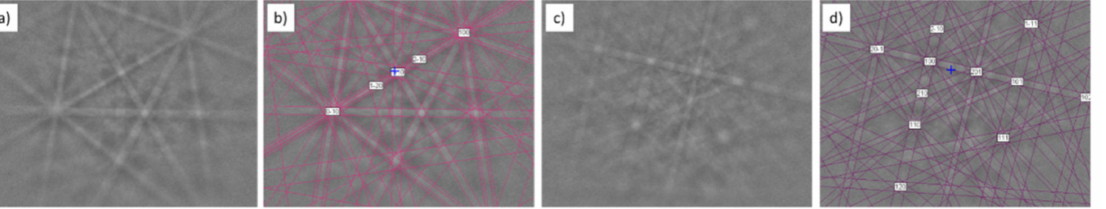
Figure 8. EBSD analysis of Ti-1.0%TiC sinter: ( a ) Kikuchi pattern of Ti 5.73 C 3.72 phase; ( b ) indexed Kikuchi pattern of TiC phase; ( c ) Kikuchi pattern of TiB phase; ( d ) indexed Kikuchi pattern of TiB phase.